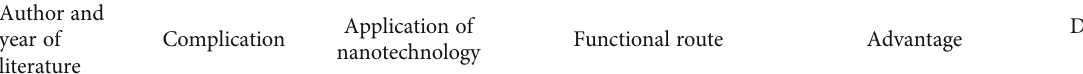
Table 1: Common complications of diabetes mellitus and application of